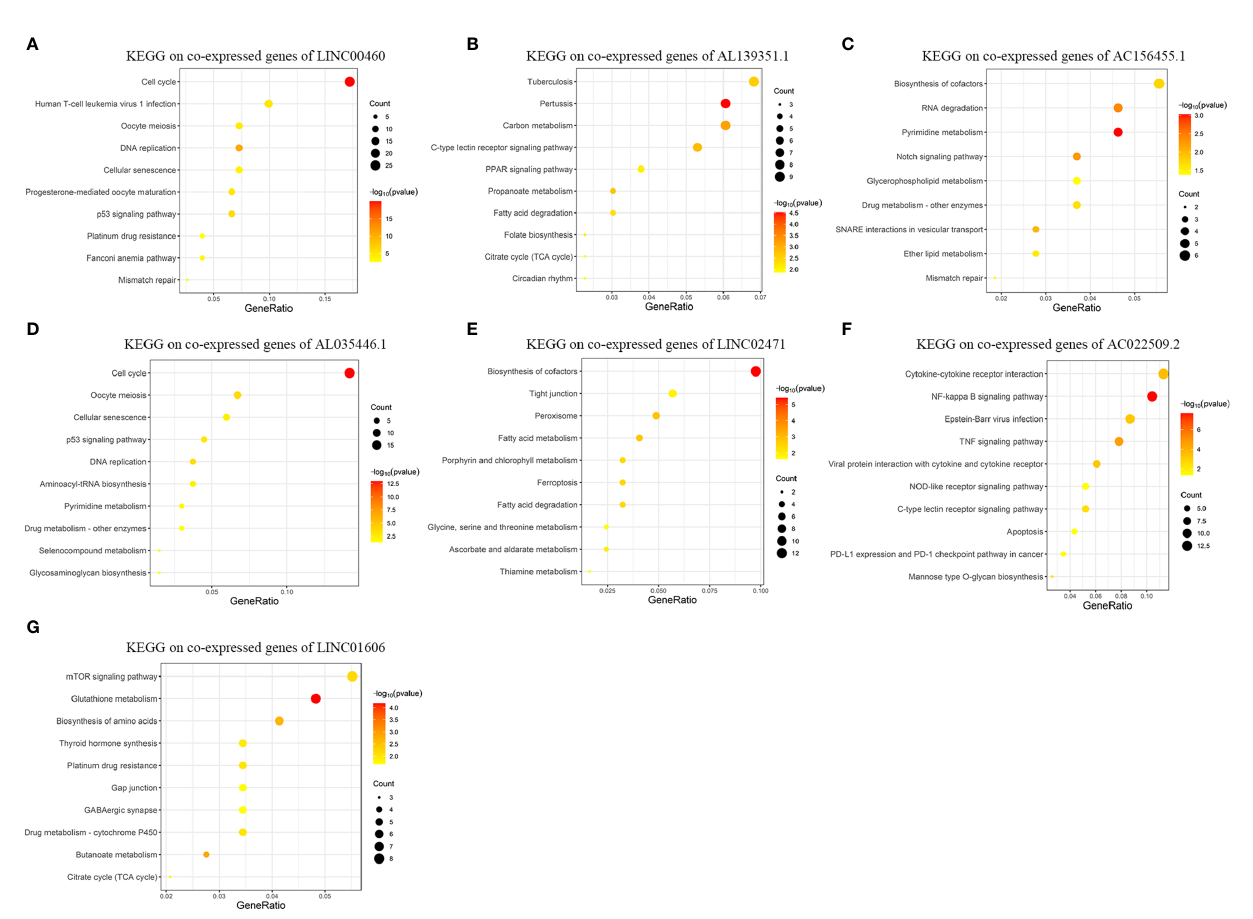
FIGURE 5 | Results of KEGG enrichment analysis on genes co-expressed with GID-lncRNAs in the risk signature. The size of the dots means the count of genes enriched in the term and the color is corresponding to the statistical signi fi cance. Gene ratio means the ratio of genes enriched in the term and all genes involved in the analysis. (A) KEGG enrichment analysis on genes co-expressed with LINC00460. (B) KEGG enrichment analysis on genes co-expressed with AL139351.1. (C) KEGG enrichment analysis on genes co-expressed with AC156455.1. (D) KEGG enrichment analysis on genes co-expressed with AL035446.1. (E) KEGG enrichment analysis on genes co-expressed with LINC02471. (F) KEGG enrichment analysis on genes co-expressed with AC022509.2. (G) KEGG enrichment analysis on genes co-expressed with